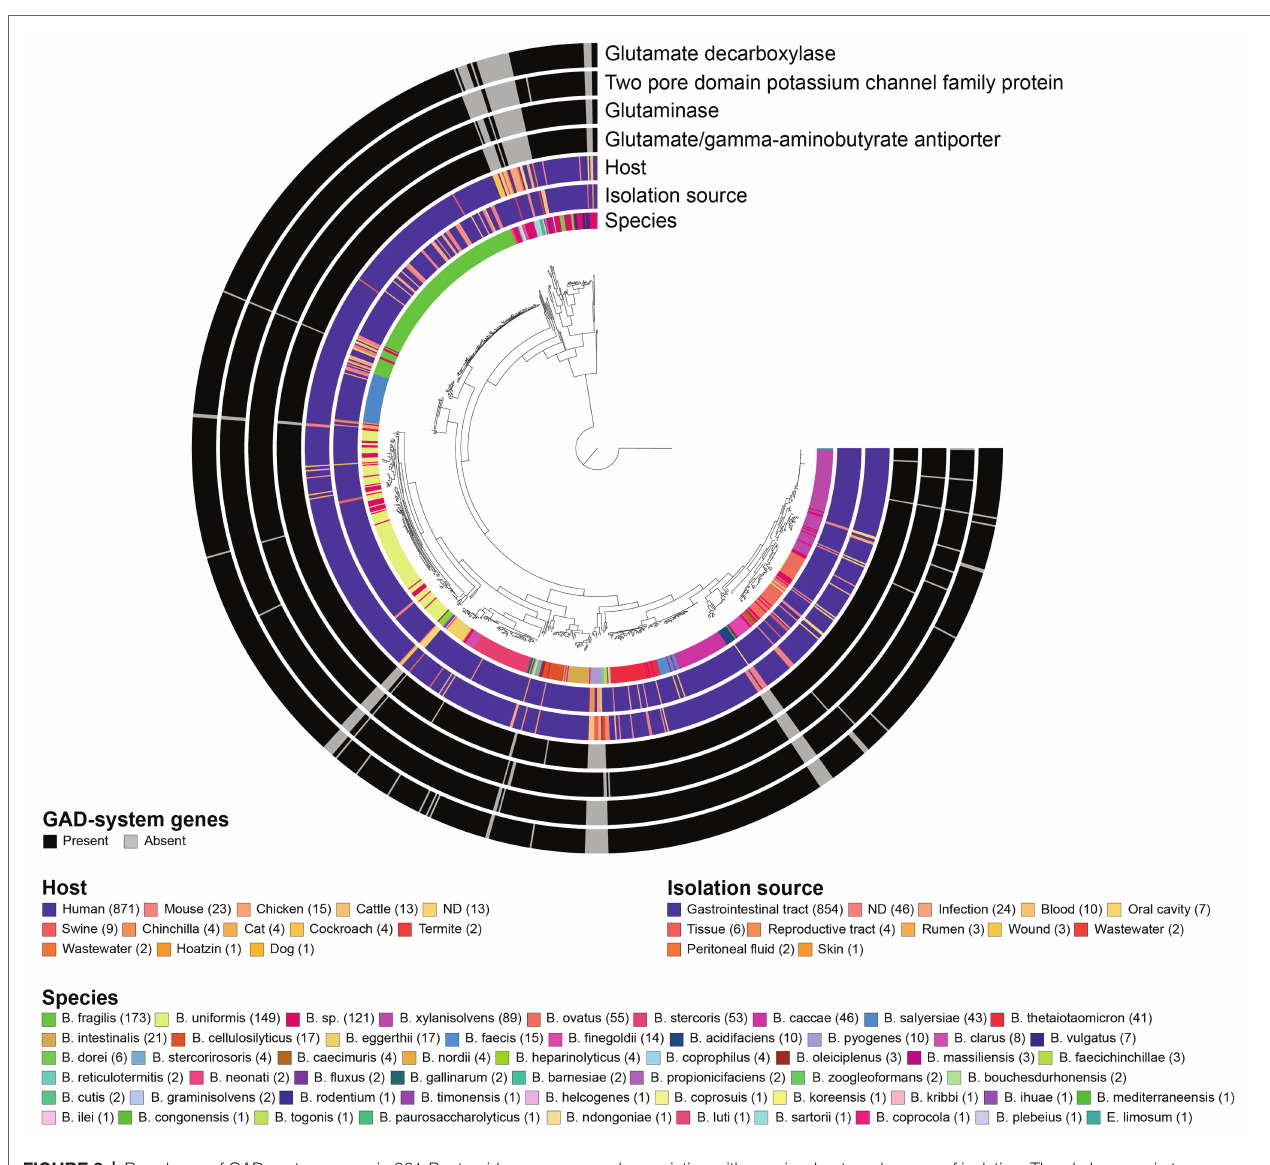
FIGURE 3 | Prevalence of GAD-system genes in 961 Bacteroides genomes and association with species, host, and source of isolation. The phylogenomic tree was generated using 90 single-copy genes (SCG) specific to Bacteroidetes , and metadata were visualized via GToTree. Eubacterium limosum DSM 20543 genome was used to root the tree. All data are available in Supplementary Data File 3